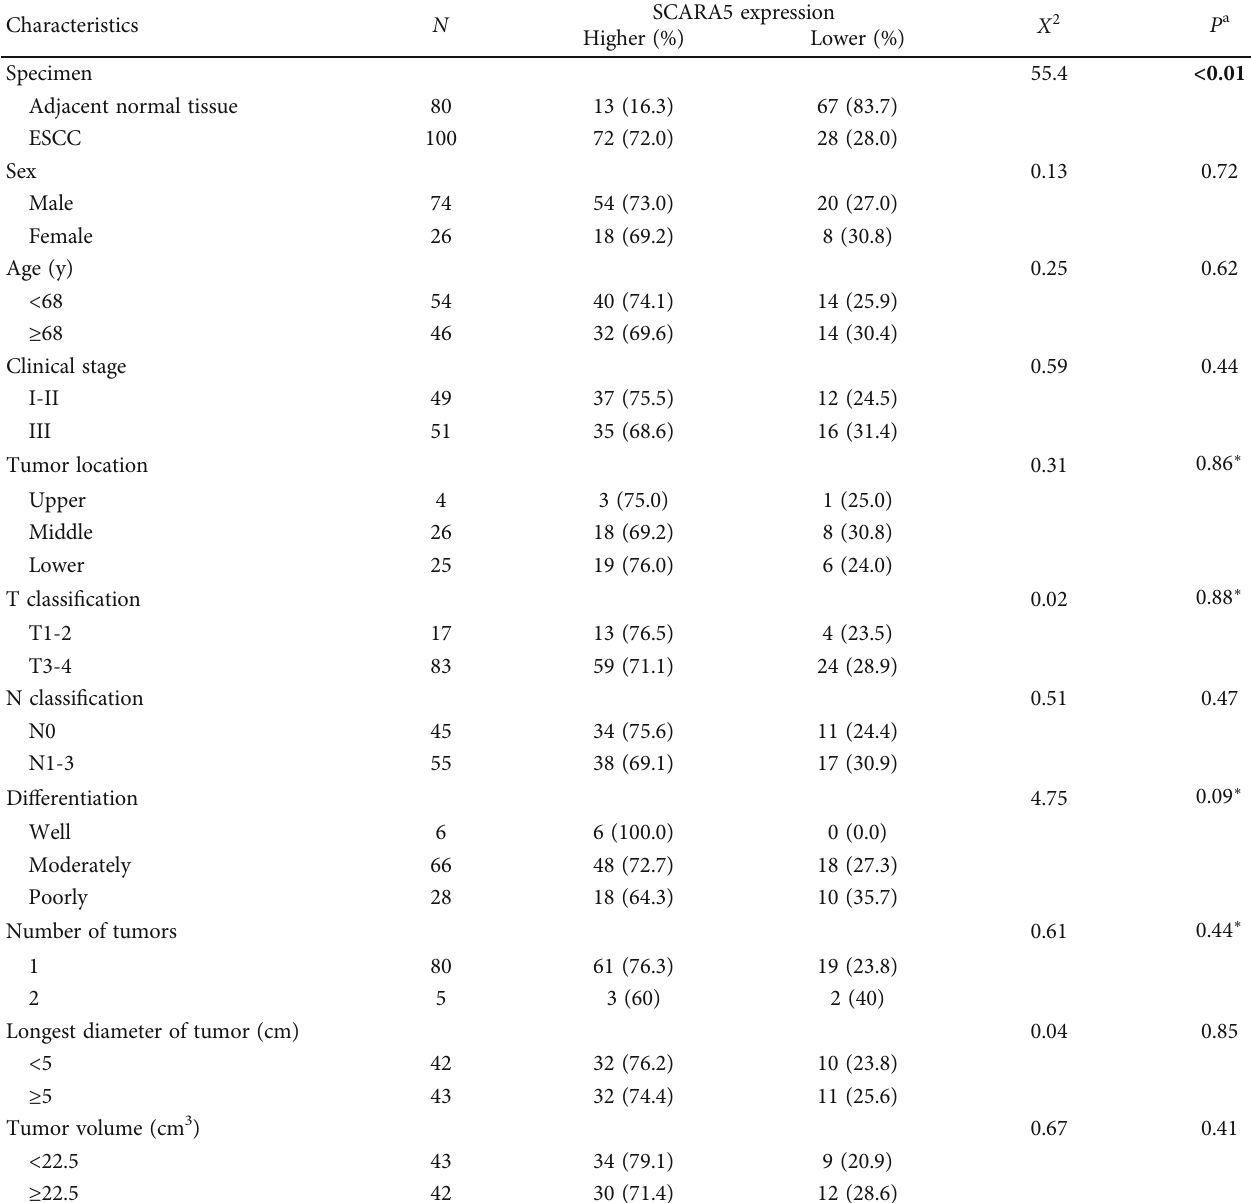
Table 4: Clinicopathological signi fi cances of SCARA5 expression in esophageal carcinoma patients.